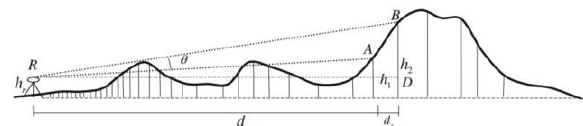
Figure 4. Non-equal interval sampling method (Han & Li, 2010) (ii) Vector Data